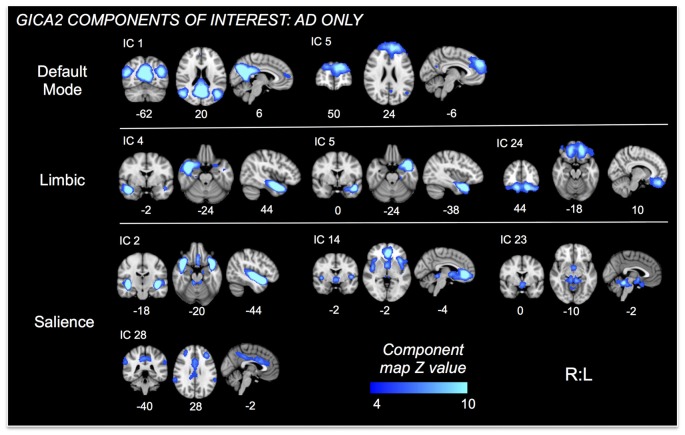
ICs of interest resulting from Group ICA of only AD subjects. These ICs were used in permutational tests exploring relationships between connectivity and HR change differences between mAD and sAD patients. ICs of interest determined via consideration of brain regions/networks typically associated with autonomic responses and regulation. Resultant ICs of non-interest, as well as those representing non-neuronal signal not shown. MNI coordinate shown below each map.